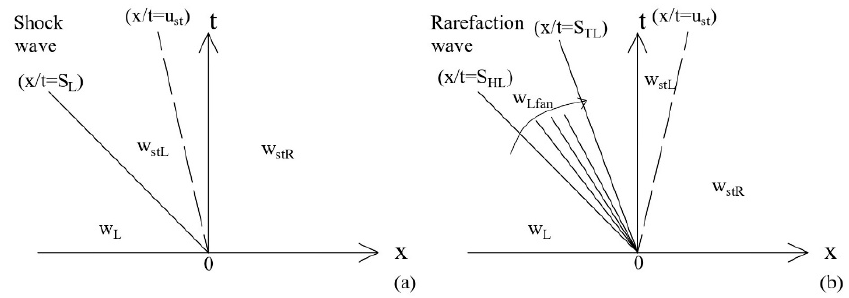
Figure A1. Solution of the Riemann problem to the left of the contact wave: ( a ) left wave is a shock wave; ( b ) left wave is a rarefaction wave.